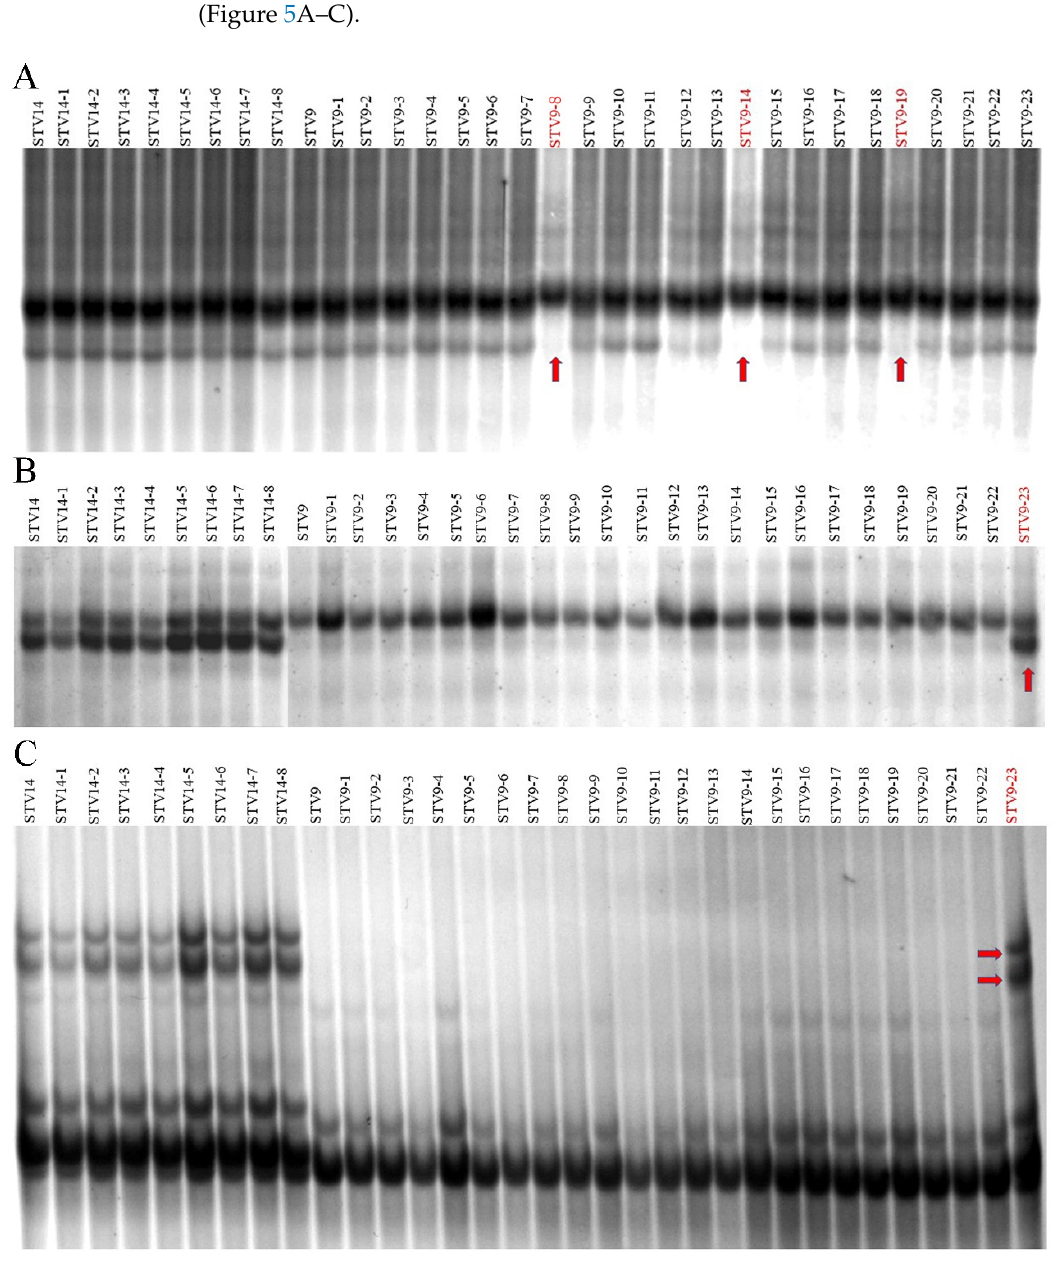
Figure 5. SSR banding pattern of the randomly selected 23 and 8 plants regenerated from the SVT9 and the SVT14, respectively. ( A ) Banding patterns of SSR marker CaM16; ( B ) banding patterns of SSR marker CaM42; ( C ) banding patterns of SSR marker CaM101. Red arrows indicate the presence or absence of SSR bands in the in vitro-regenerated plants.